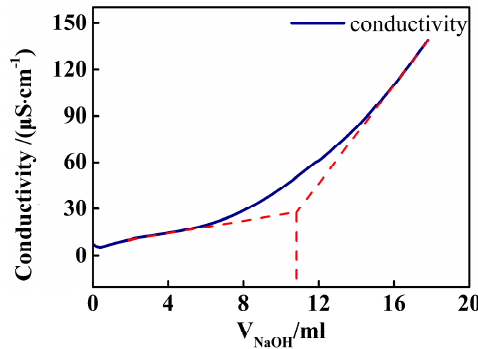
Figure 7. Conductometric titration curves of the PSA suspension, a case of PSA4.